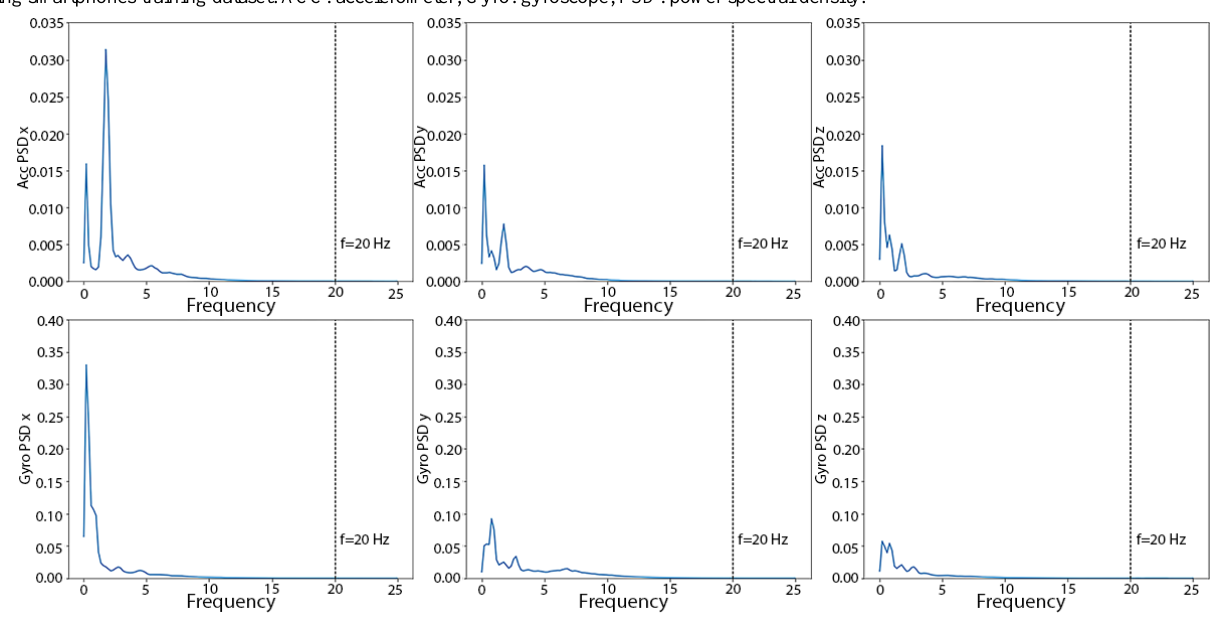
Figure 3. Triaxial (x, y, and z) power spectra density curves of accelerometer (top row) and gyroscope (bottom row) of the human activity recognition using smartphones training dataset. ACC: accelerometer; Gyro: gyroscope; PSD: power spectral density.